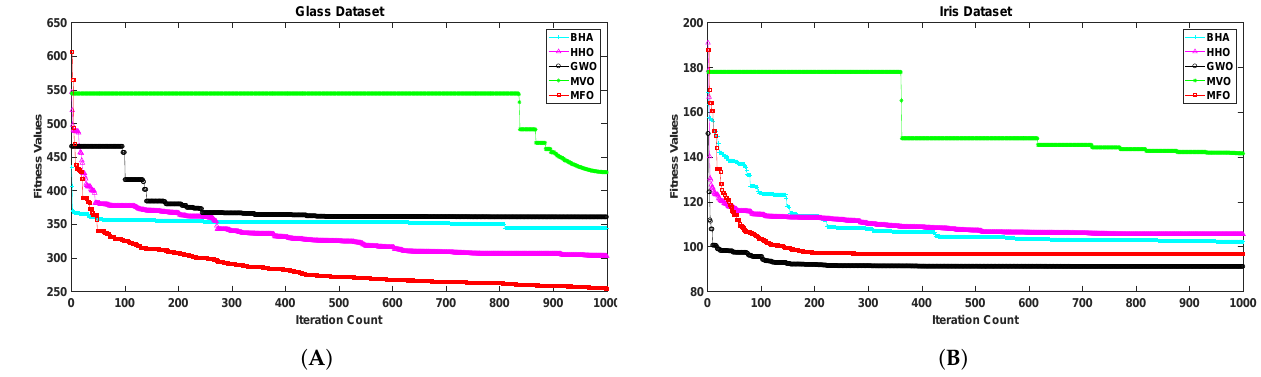
Figure 5. Variation in the best fitness values of algorithms for datasets ( A ): Glass, ( B ): Iris with respect to iterations.